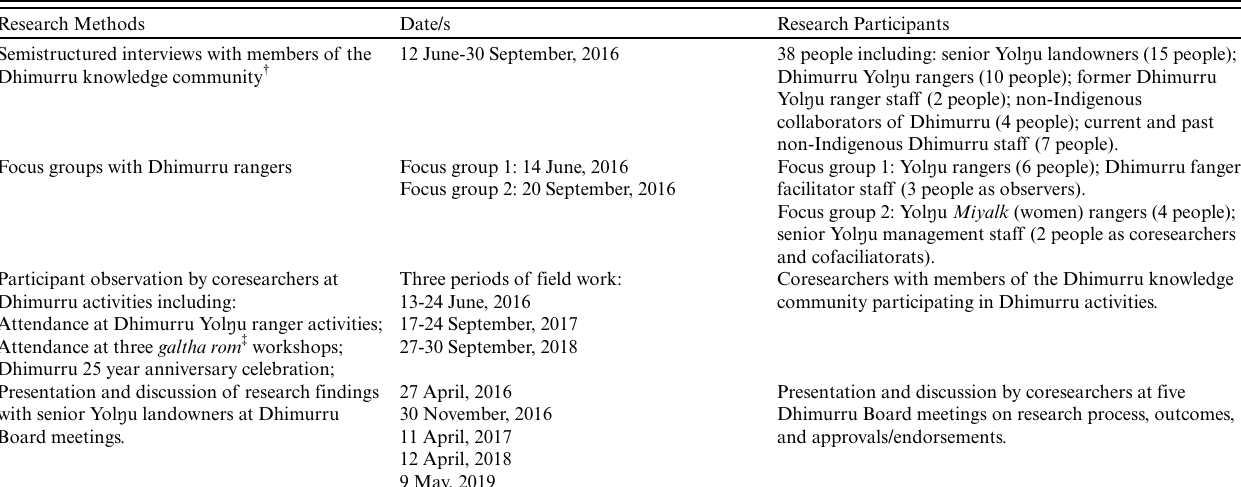
Table 2 . Data collected, methods used, and participants involved in the